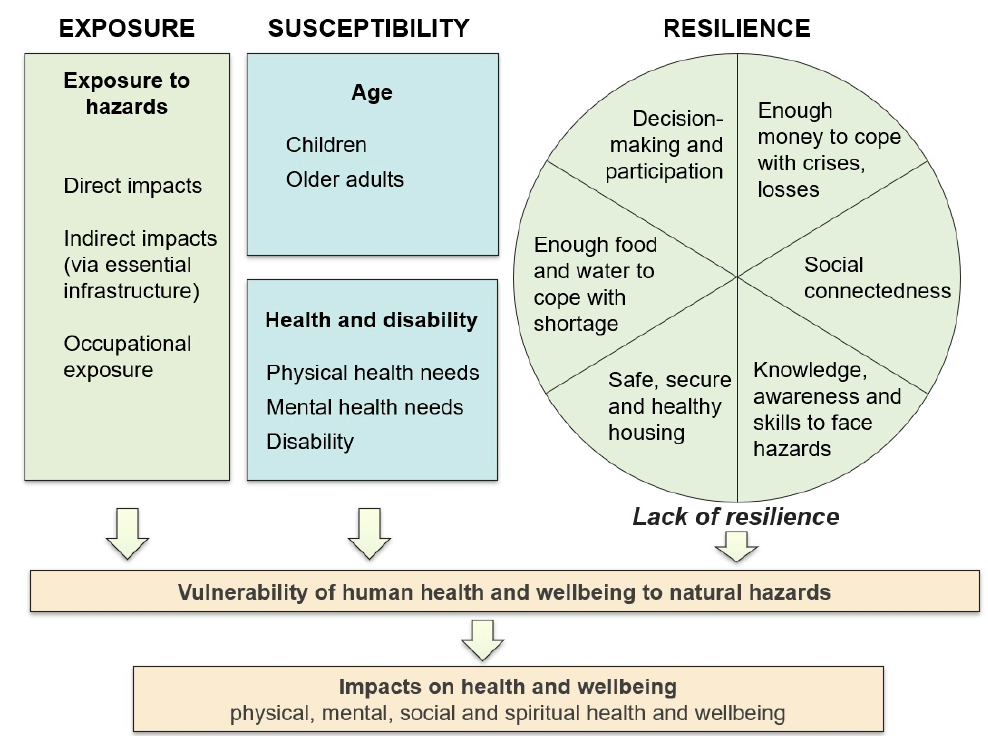
Figure 3. Conceptual framework for social vulnerability to natural hazards (own figure, based on conceptual models by Birkmann et al. [33], USGCRP [17], Wisner et al. [46,55] and Durie [57]). Table 2. Dimensions of social vulnerability to natural hazards, and their rationale [16,17,23–25,61,62]. Social Vulnerability Rationale Dimension